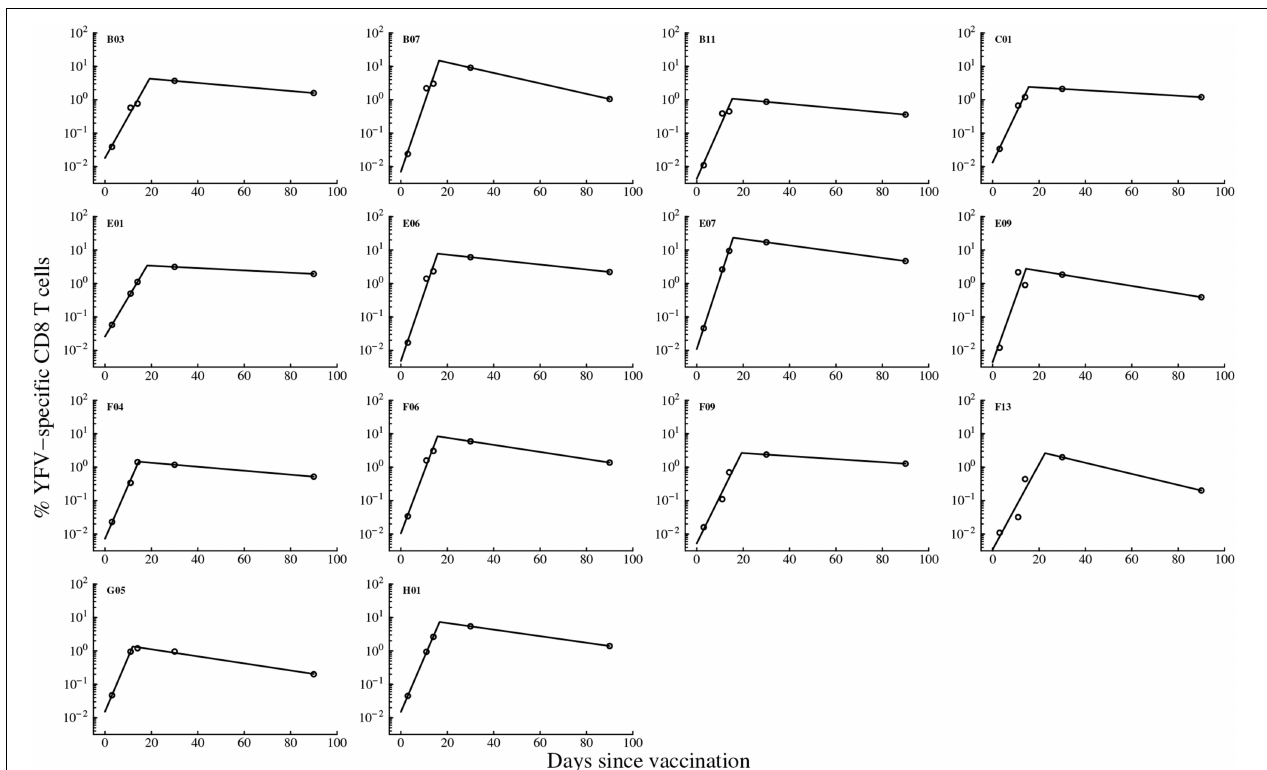
FIGURE 2 | Kinetics of the YF-17D-specific CD8 T cell response in vaccinated volunteers and predictions of the mathematical model. We fit the mathematical model given in Equation (1) (see Materials and Methods) to experimental data on the percent of virus-specific CD8 T cells in blood of volunteers and estimate model parameters. Only subjects with at least 5 measurements were included in the analysis